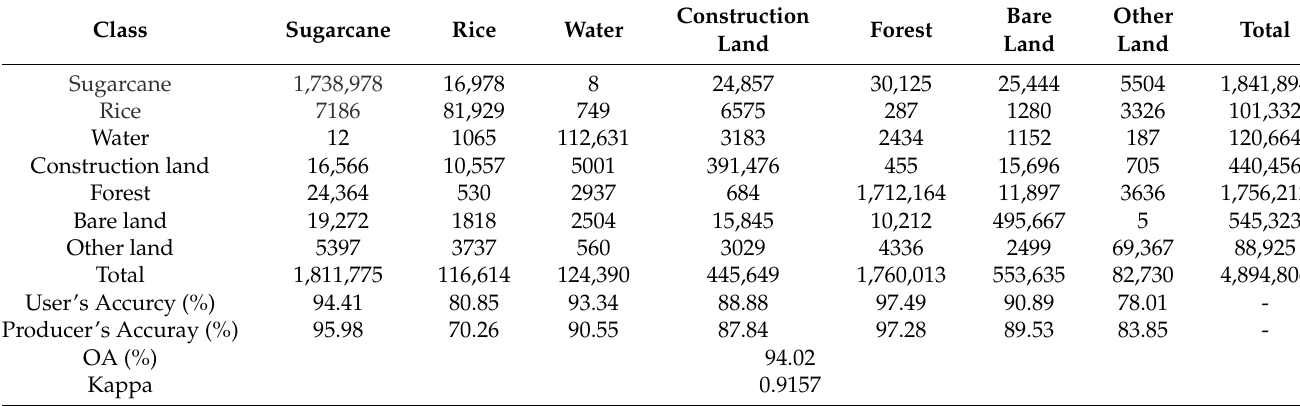
Table 9. Accuracy evaluation table of classification results in 2010.